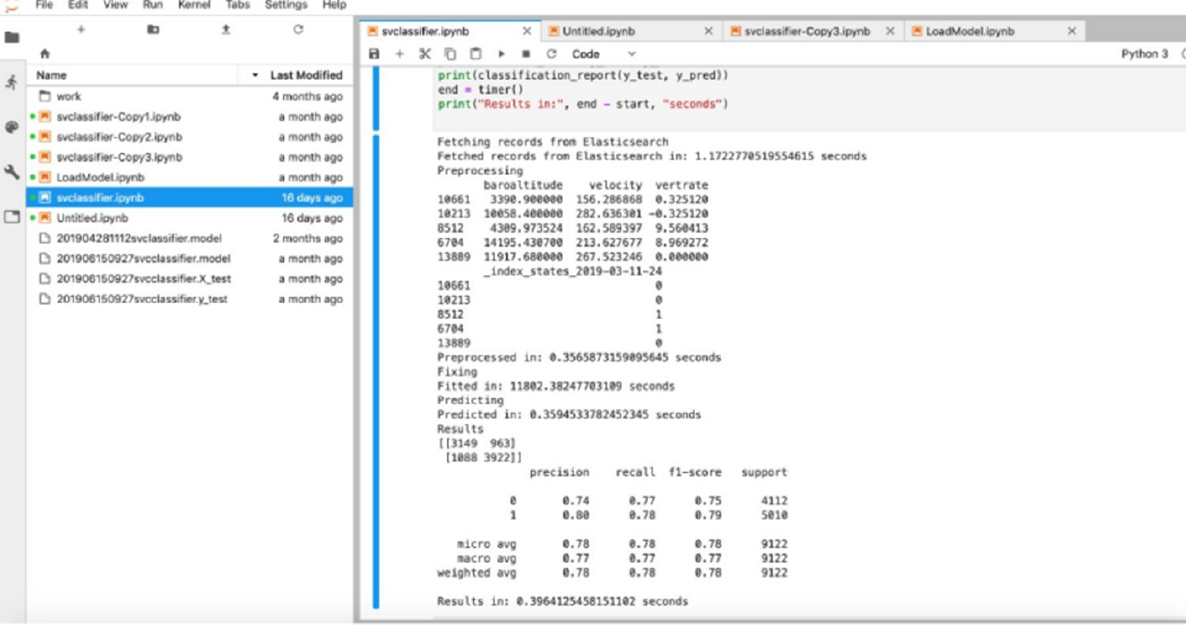
Figure 4. Jupyter Output of Sample Data and Confusion Matrix.